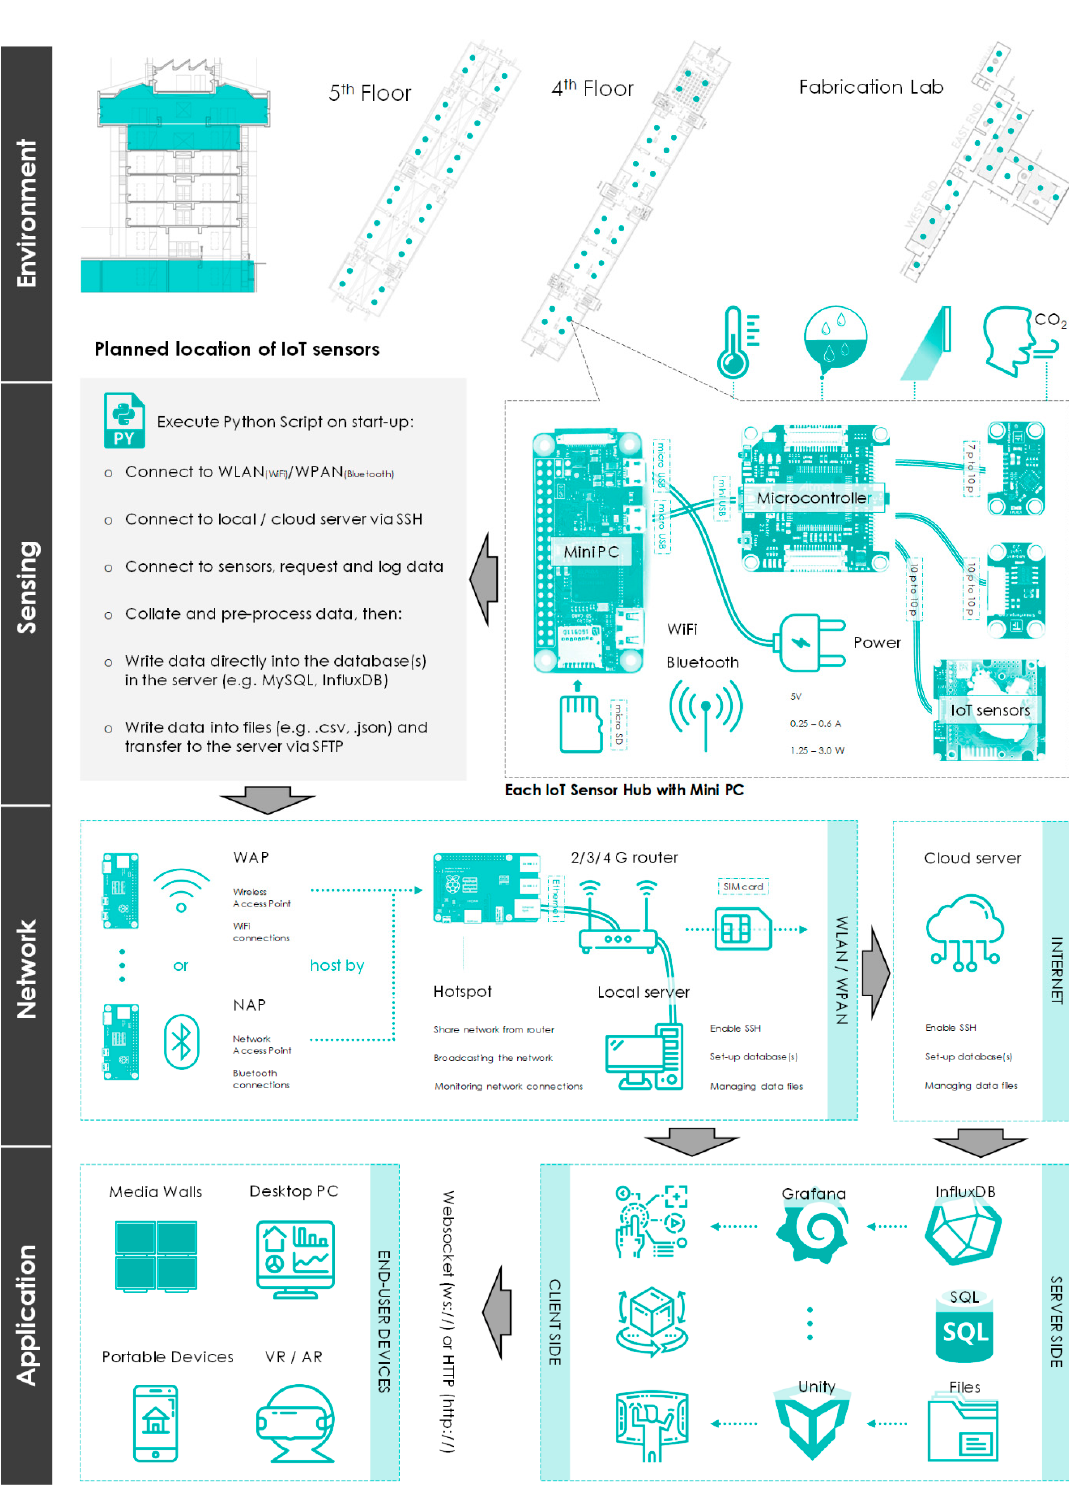
Figure A1. The Overall Planning of the Deployment of IoT sensors in Marylebone Campus (source: composed by the author, a few icons have been used in this figure retrieved from Flaticon.com) [40].